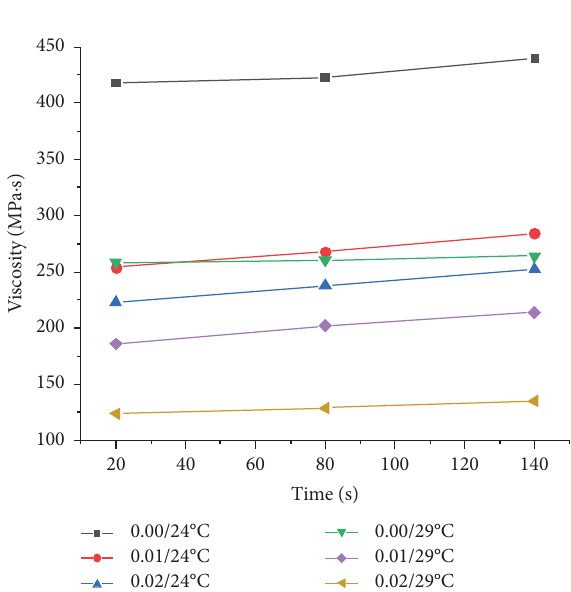
Figure 10: Viscosity of epoxy resin with a k 0.01 or 0.02 at 24 ° C or 29 ° C.